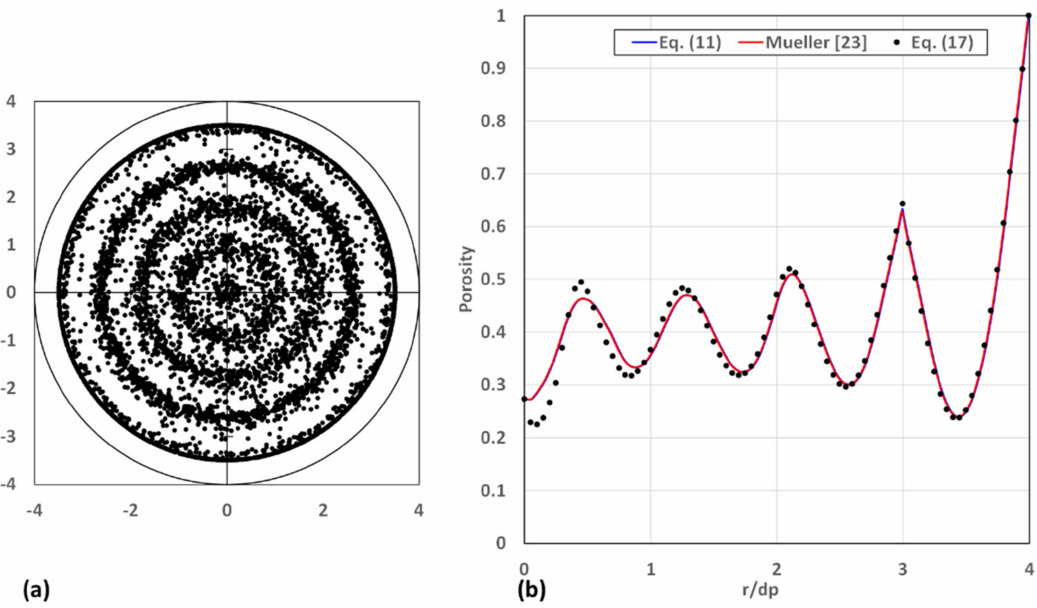
Figure 9. ( a ) Positions of centres of the spheres and ( b ) the radial variations in porosity based on Equation (11) and the approximate expression and obtained by Mueller [23] for D / d p = 7.99. It can be observed in Figure 9b that, for 1.74 < r / d p ≤ 3.995, the agreement